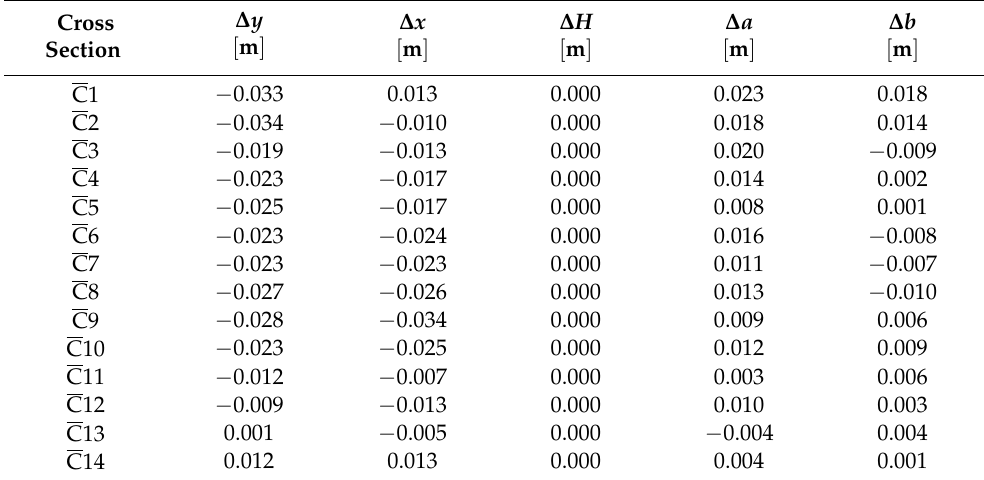
Table 6. Differences of ellipse modeling results between the TS- and the UAS-based data sets.